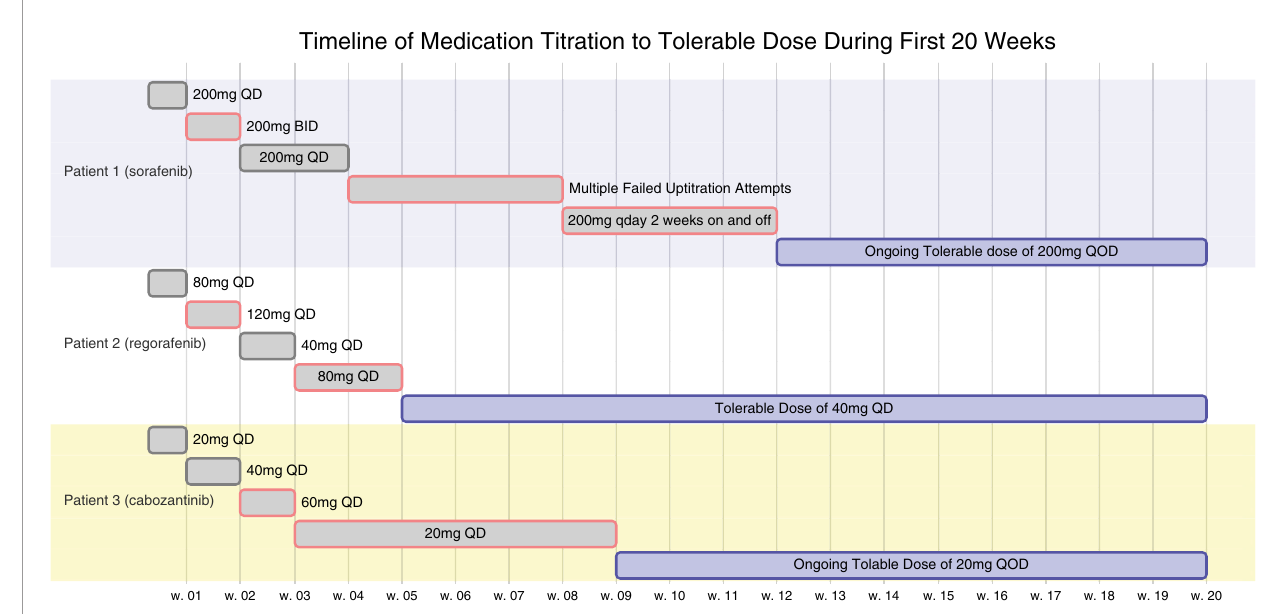
FIGURE 1 | All 3 patients underwent multiple attempts at titrating their respective TKI therapies to the FDA label dosages but were limited by toxicities. Their titration timeline is as above. At 6 weeks, none of the patients would have met their corresponding minimum FDA label dosages of sorafenib 400mg QOD, regorafenib 80mg QD, or cabozantinib 20mg QD.